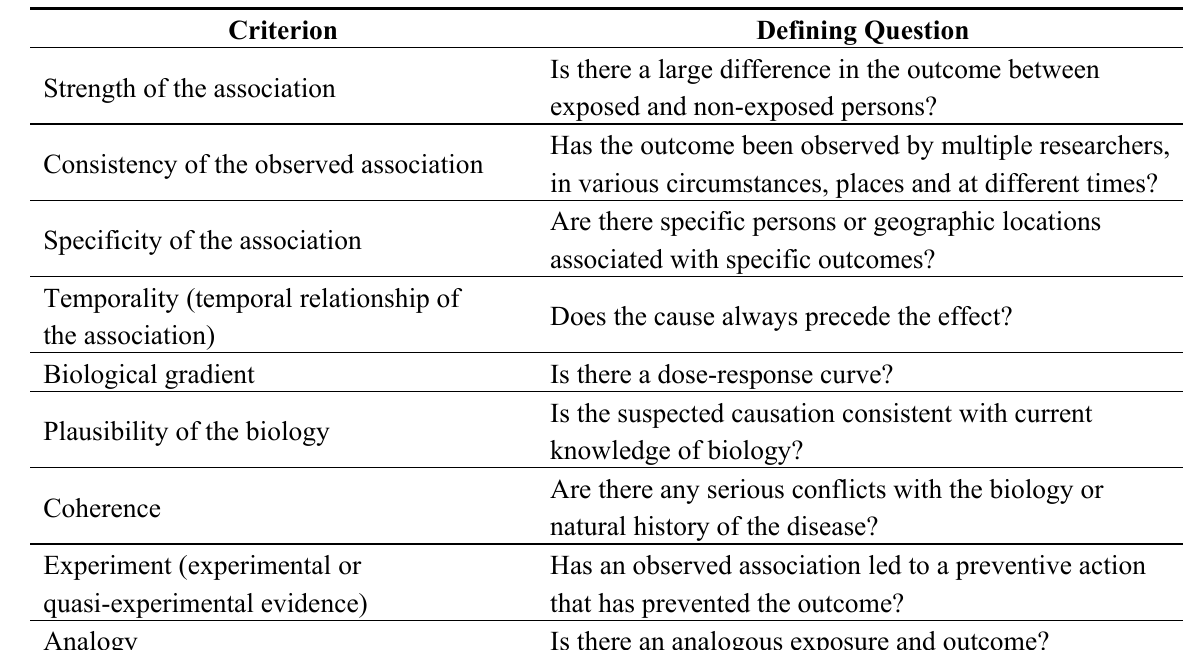
Table 1. Hill’s criteria for causality in a biological